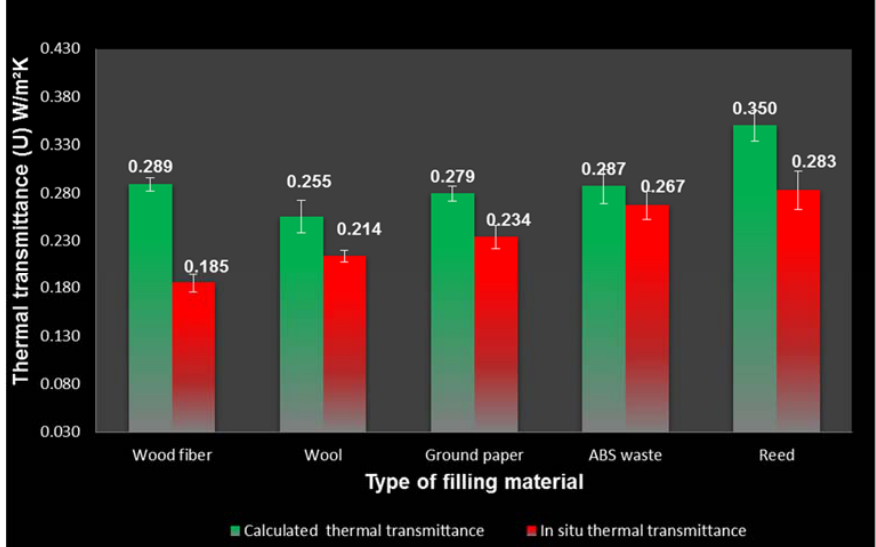
Figure 7. Mean values of thermal transmittance for the entire test cycle.